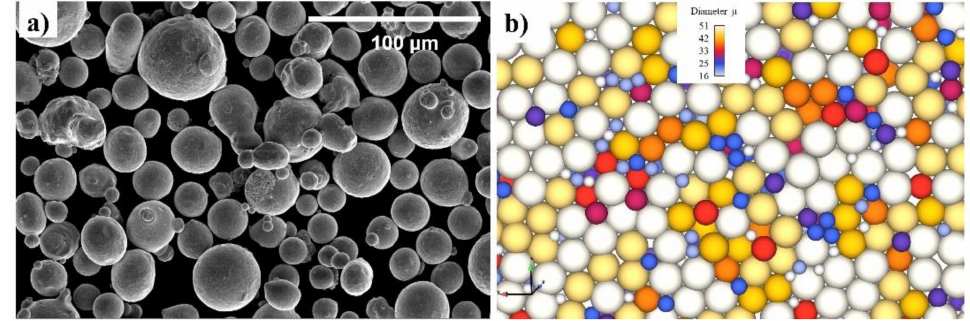
Figure 1. ( a ) Powder particle SEM and ( b ) discrete element